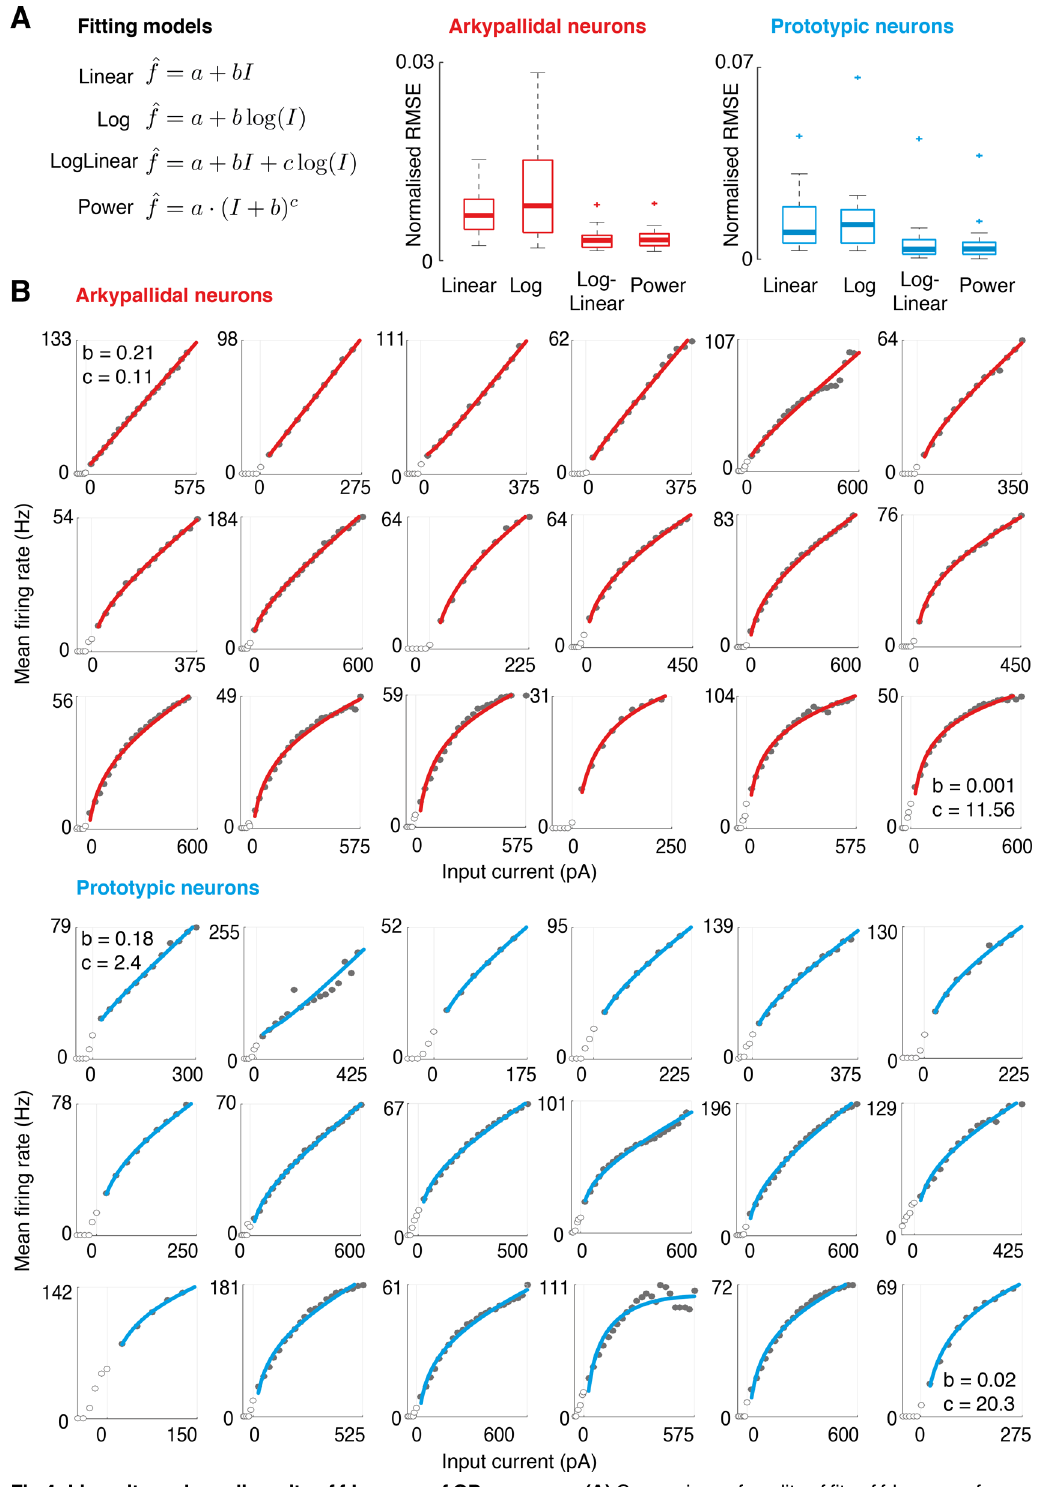
Fig 4. Linearity and non-linearity of f-I curves of GPe neurons. (A) Comparison of quality of fits of f-I curves of arkypallidal or prototypic neurons to 4 different functions (linear, logarithmic, a combination of logarithmic and linear, or a power function). The fits were assessed by root mean squared error (RMSE). Note that the best fits (lowest RMSE values) arose from using the combination of logarithmic and linear as well as from the power function. Plots